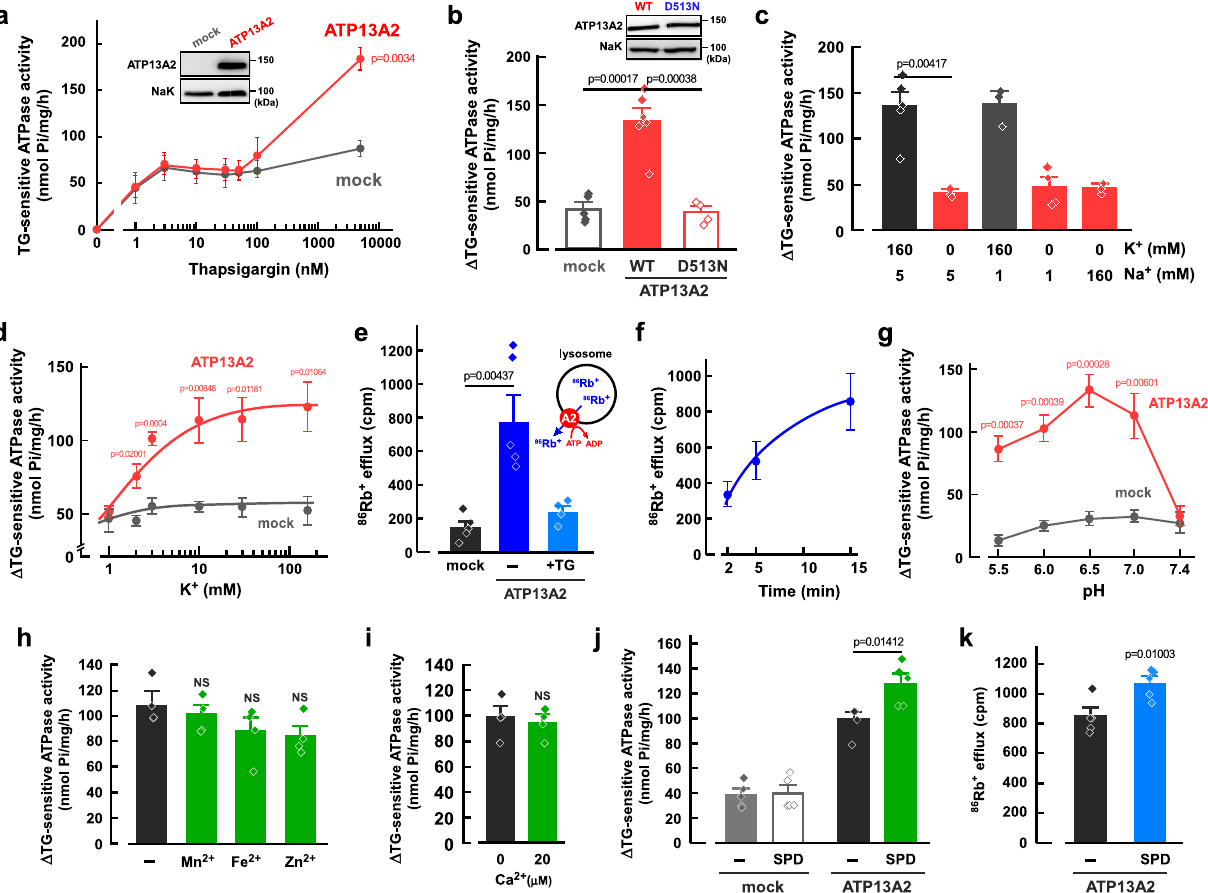
Fig. 1 | Properties of cation transport of ATP13A2. a Thapsigargin (TG)-sensitive ATPase activity in the ATP13A2- and mock-transfected HEK293 cells. ( n =4 inde- pendentreplicates). InsertshowsWesternblotimagesofATP13A2(~150kDa)and Na + ,K + -ATPase (NaK; ~100kDa). Statistical signi fi cance was determined by two- tailed unpaired Student ’ s t test. b Δ TG-sensitive ATPase activities (the difference between 50nM TG- and 5 μ M TG-sensitive activities) in the ATP13A2 WT-, D513N- andmock-transfectedcells.( n =4 – 6independentreplicates).InsertshowsWestern blot images of ATP13A2 (~150kDa) and Na + ,K + -ATPase (NaK; ~100kDa). Statistical signi fi cancewasdeterminedbytwo-tailedunpairedStudent ’ s t test. c Δ TG-sensitive ATPaseactivitiesintheATP13A2-expressingHEK293cellsatvariousconcentrations of Na + and K + . ( n =3 – 5 independent replicates). Statistical signi fi cance was deter- mined by two-tailed unpaired Student ’ s t test. d K + -dependent activation of Δ TG- sensitive activity in the ATP13A2- and mock-transfected cells. ( n =4 independent replicates). Statistical signi fi cance was determined by one-way ANOVA. e ATP- dependent 86 Rb + ef fl ux from lysosomes of the ATP13A2- and mock-transfected HEK293 cells. Effect of TG (5 μ M) on the 86 Rb + ef fl ux was examined. ( n =4 –